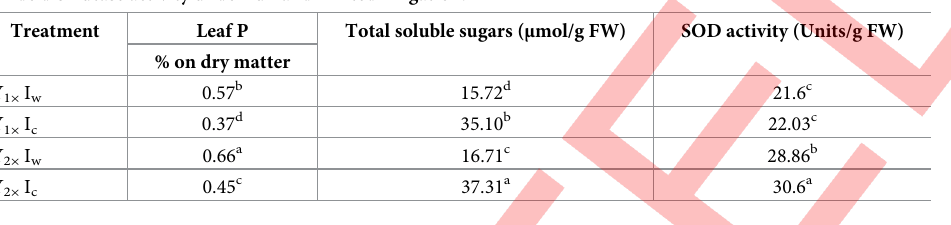
Where Y 1 (first year), Y 2 (second year), I w (full irrigation), I s (limited irrigation). Means values that were followed by the same letter in each column are not significantly different using PLSD method at P �